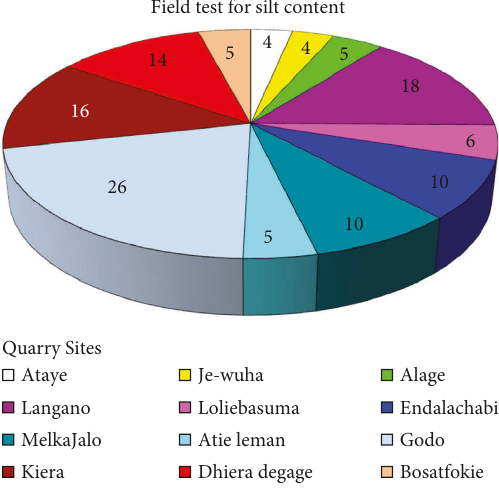
Figure 2: Silt content (source: during field study).